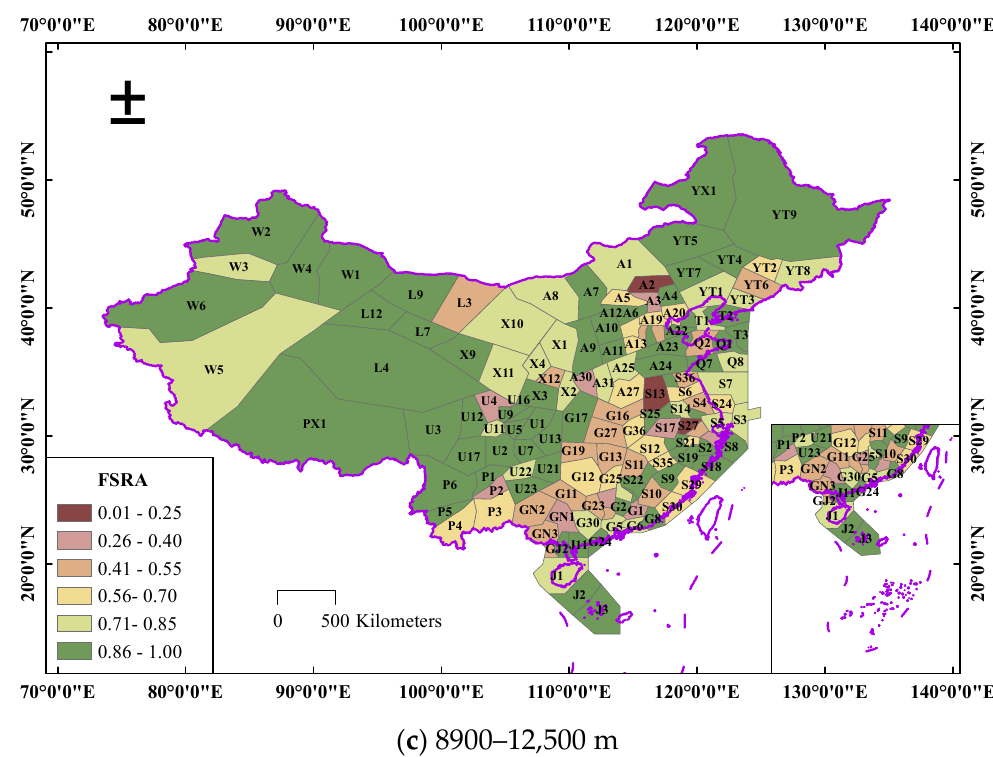
Figure 8. Spatial distribution of FSRA in Chinese airspace.